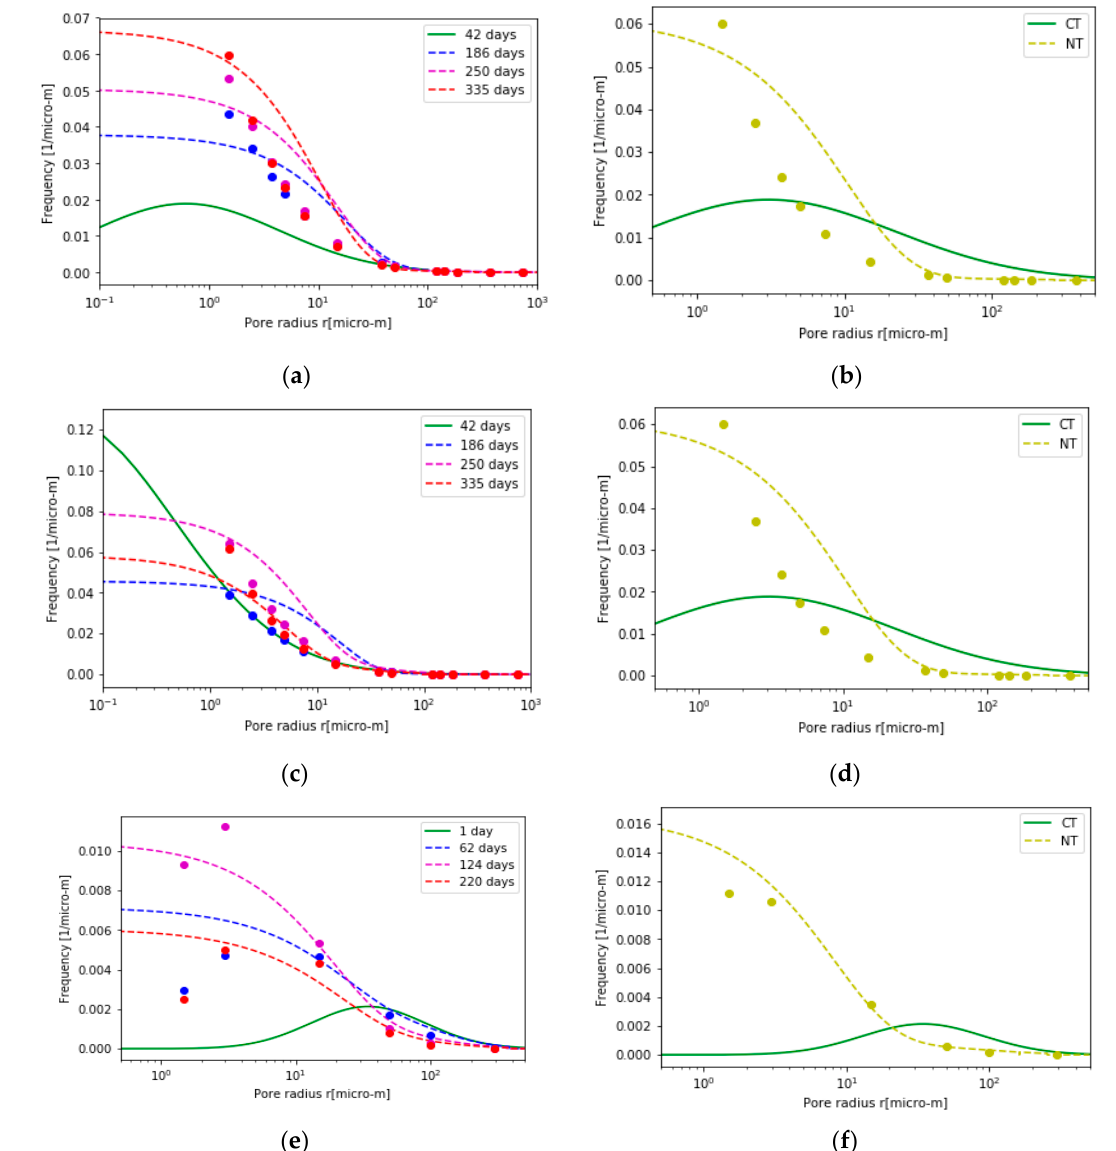
Figure 2. Evolution of soil pore size distribution ( a ) Fuentes et al. [89]: Post CT through a season for 0–3 cm depth. ( b ) Fuentes et al. [89]: Change in tillage regime from CT to NT for 0–3 cm depth. ( c ) Fuentes et al. [89]: Post CT through a season for 3–6 cm depth) Fuentes et al. [89]: Change in tillage regime from CT to NT for 3–6 cm depth. For ( a , c ), the blue, pink and red dots represent the frequencies for 186, 250 and 335 days after tillage while the dashed lines of the same color show the corresponding predicted frequencies. For ( b , d ), the lime-yellow dots and dashed line represents the observed and predicted frequencies for NT. In both graphs, the green line shows the initial PoSD following CT (in this case, 42 days when the first measurement was taken). ( e ) Peña-Sancho et al. [42]: Post CT through a season for 10–20 cm depth. The blue, pink and red dots represent the frequencies for 62, 124 and 220 days after tillage while the dashed lines of the same color show the corresponding predicted frequencies. ( f ) Peña-Sancho et al. [42]: Change in tillage regime from CT to NT for 10–20 cm depth. The lime-yellow dots and dashed line represents the observed and predicted frequencies for NT. In both graphs, the green line shows the initial PoSD following CT (in this case, 1 day when the first measurement was taken).